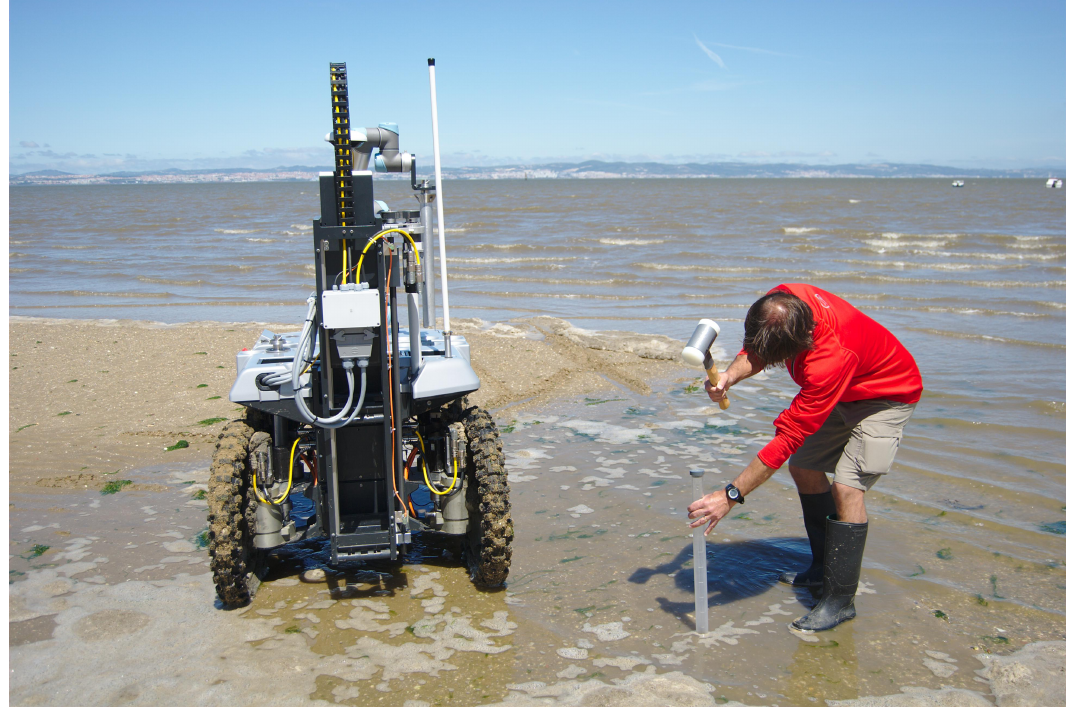
Figure 2. The ground vehicle drilling the terrain side-by-side a human expert handling a conventional manual tool. The human expert hammers an acrylic hollow cylinder until a desired depth is reached. Then, the cylinder must be gently pulled in order to ensure that the sediments do not fall. All of this process is time consuming and physically demanding. Conversely, the robot drills effortlessly